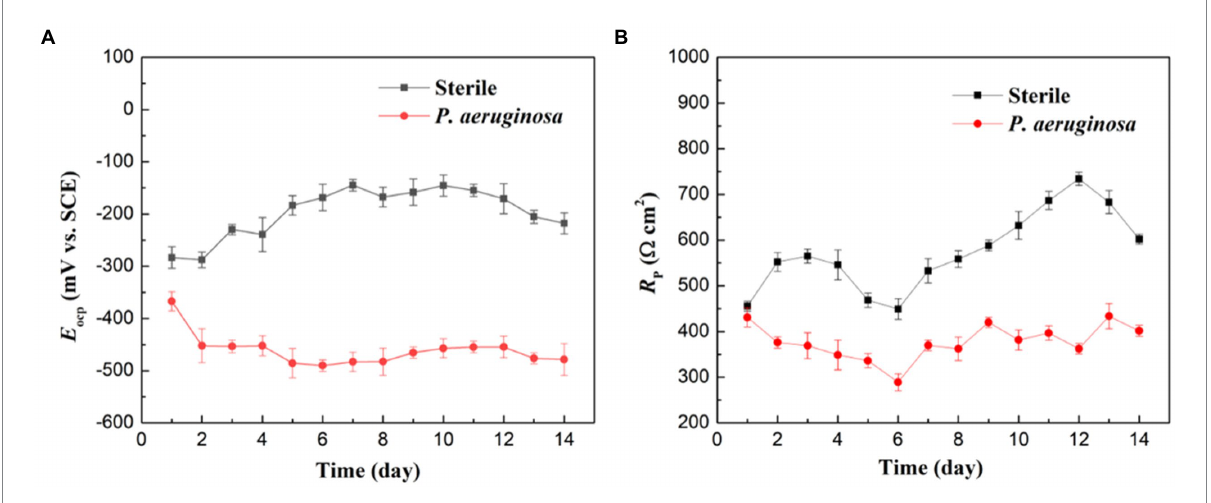
FIGURE 4 (A) OCP and (B) LPR measurements of the HEA coupons after immersion in sterile and P. aeruginosa -inoculated medium for 14